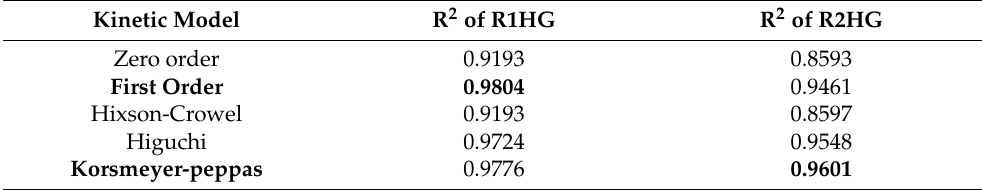
Table 2. Values of coefficients of determination obtained for all the kinetic models used. Kinetic Model R 2 of R1HG R 2 of R2HG Zero order 0.9193 First